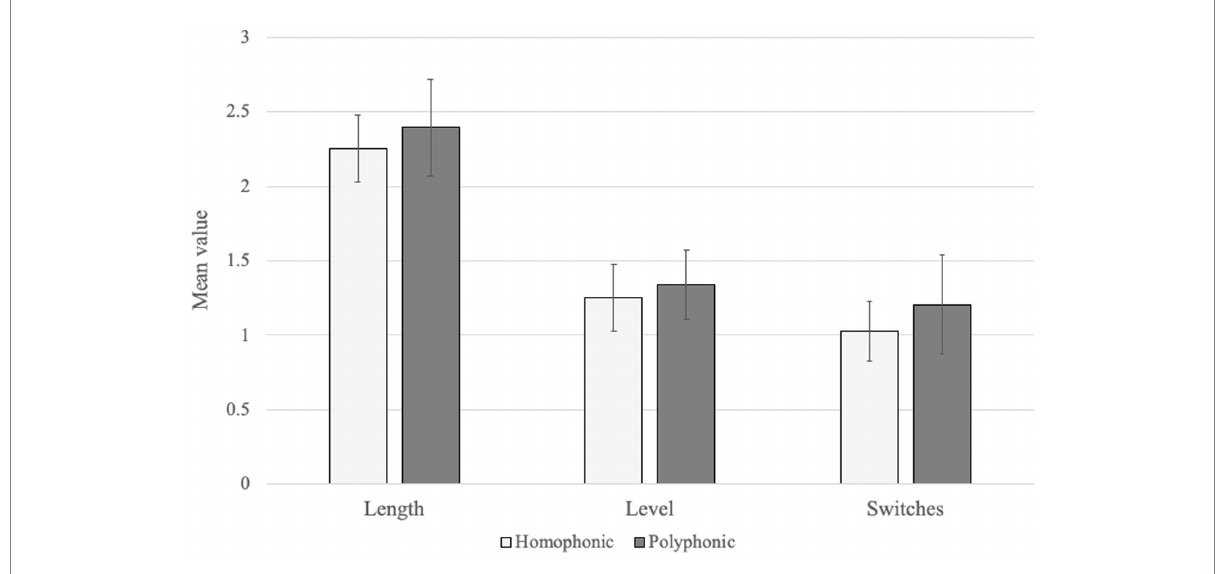
FIGURE 4 Mean value and standard deviation of pattern length, number of levels, and number of actor switches, by homophonic and polyphonic piece structure (Group